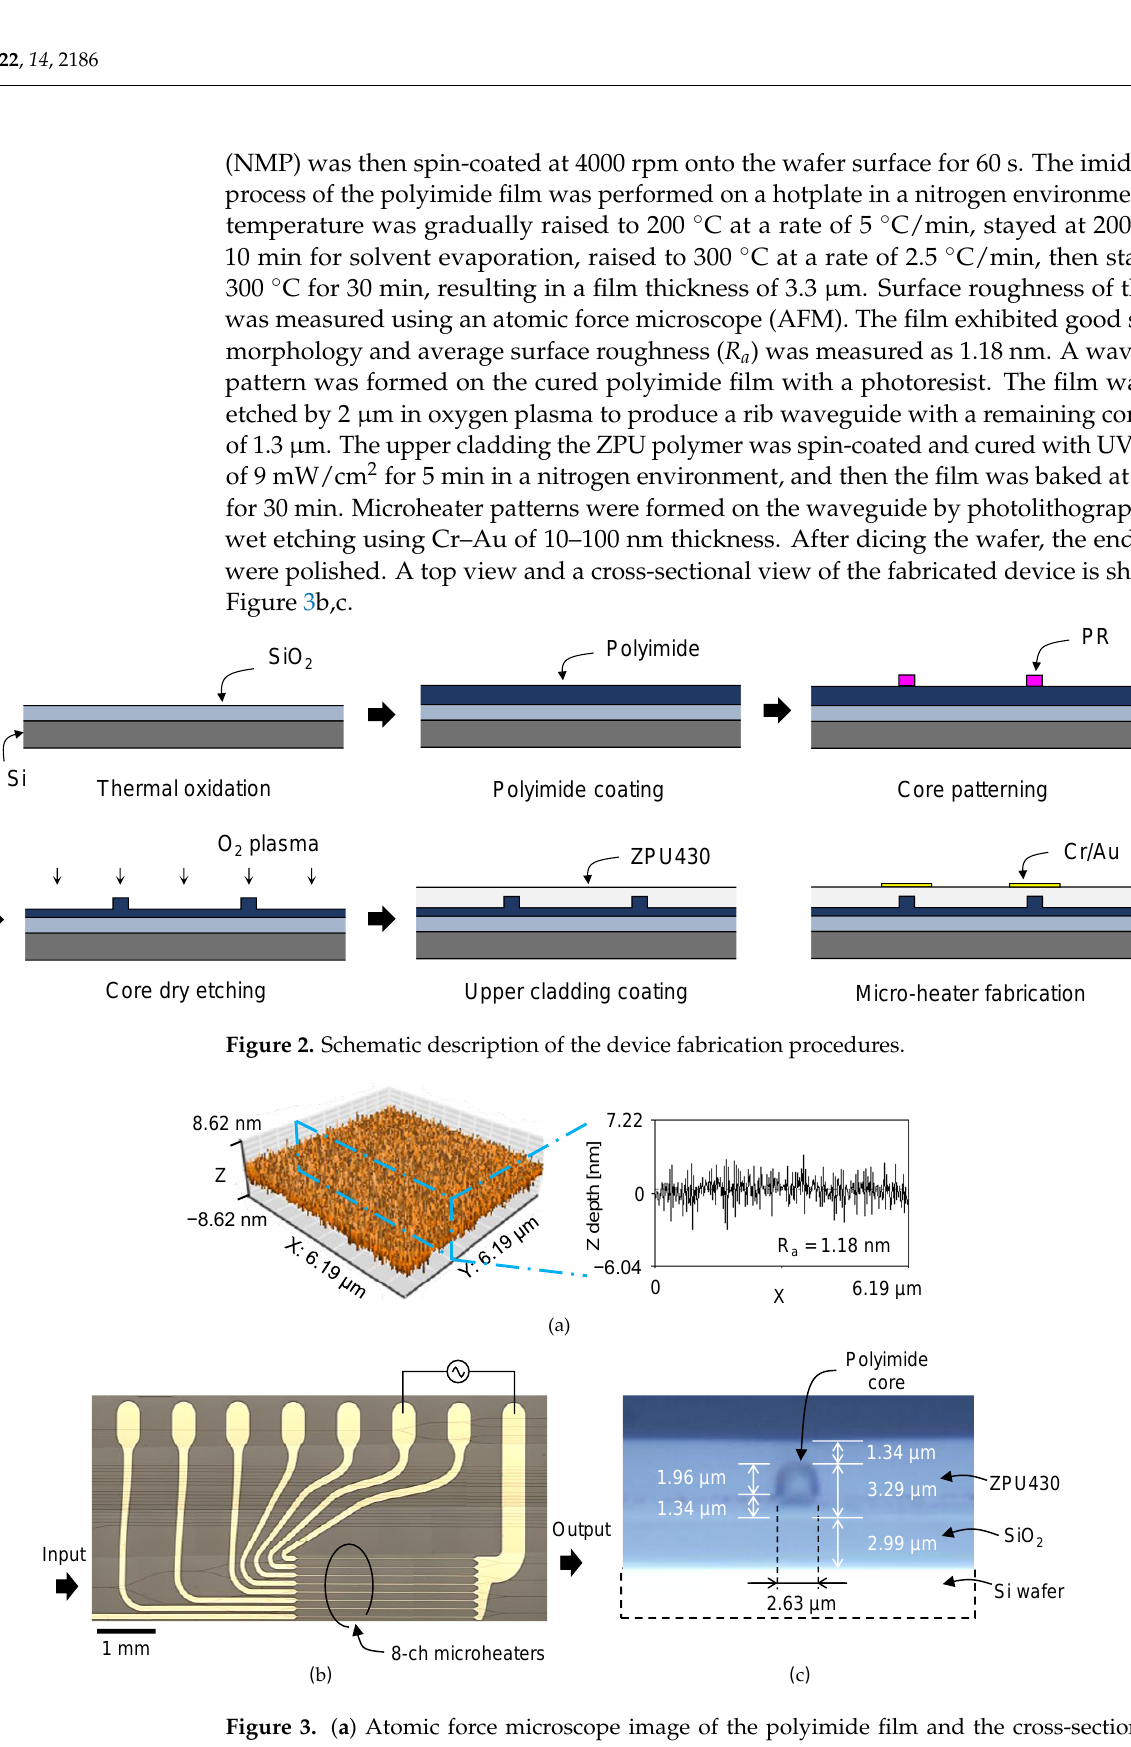
Figure 3. ( a ) Atomic force microscope image of the polyimide film and the cross-sectional plot showing depth profile. The average roughness ( R a ) of the film surface was less than 2 nm. Microscopic images of the fabricated phase modulator array: ( b ) top-view showing 1 × 8 power splitter, 8-ch phase modulator array, and 4-ch MZI array, which shows the half of the fabricated device and ( c ) waveguide cross-section formed by cleaving.